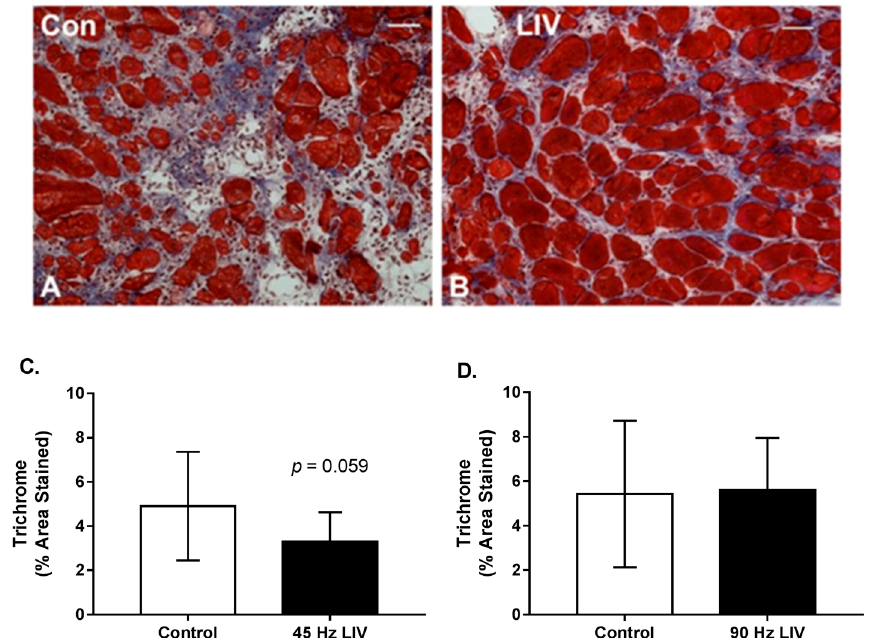
Figure 4. Fibrosis may be reduced in lacerated muscle following low-intensity vibration. ( A , B ) Representative images of trichrome-stained sections at day 14 following laceration of the gastrocnemius muscles (scale bar = 50 µ m, 20 × magnification); ( C , D ) Collagen accumulation was quantified as percent blue pixels in three to six 20 × fields per muscle in Masson’s trichrome-stained sections. Data are presented as mean ± SE. * p ≤ 0.05.